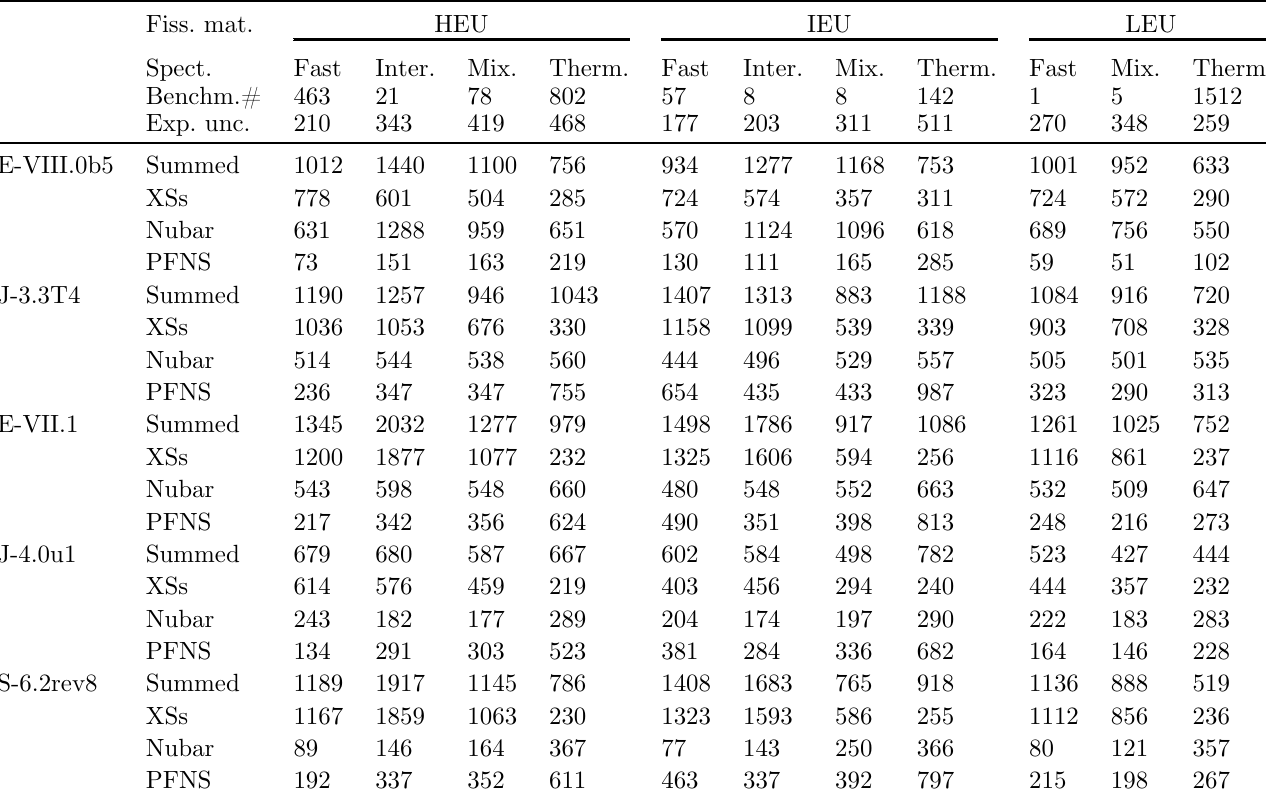
Table 1. Impact of different 235 U nuclear data covariances in ICSBEP suite averaged for fi ssile material and spectrum. Fiss. mat. HEU IEU LEU Spect. Fast Inter. Mix. Therm. Fast Inter. Mix. Therm. Fast Mix. Therm. Exp. unc. 210 343 419 468 177 203 311 511 270 259